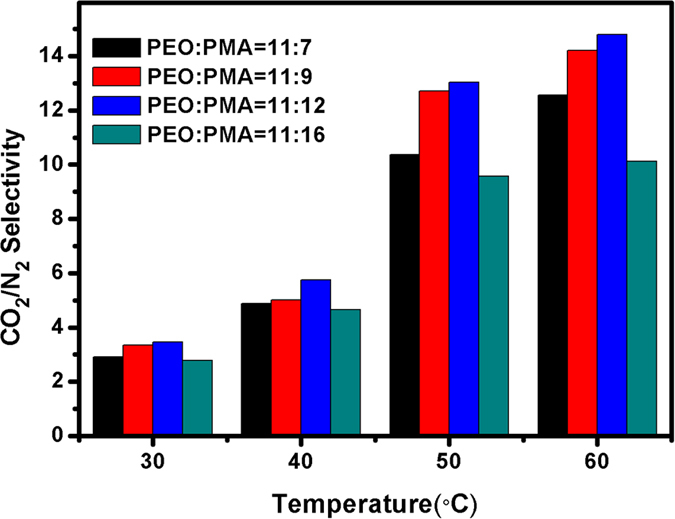
αCO2/N2 with PEO:PMA = 11:7(black), 11:9(red), 11:12(blue) and 11:16(green) at different temperature.